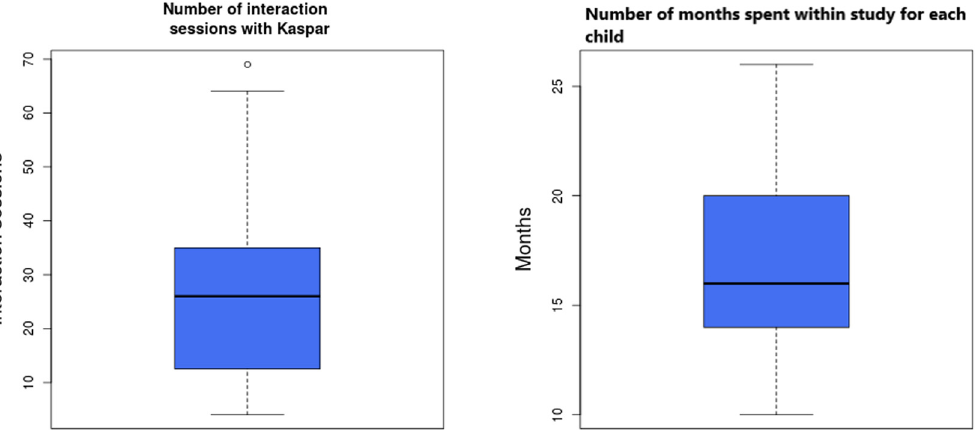
Figure 5: Box plots showing distribution of interactions with Kaspar and length of study period ( middle line denotes median, shaded area shows the interquartile range [ i.e. the middle 50% of results ] and whiskers describe interquartile range times 1.5 )